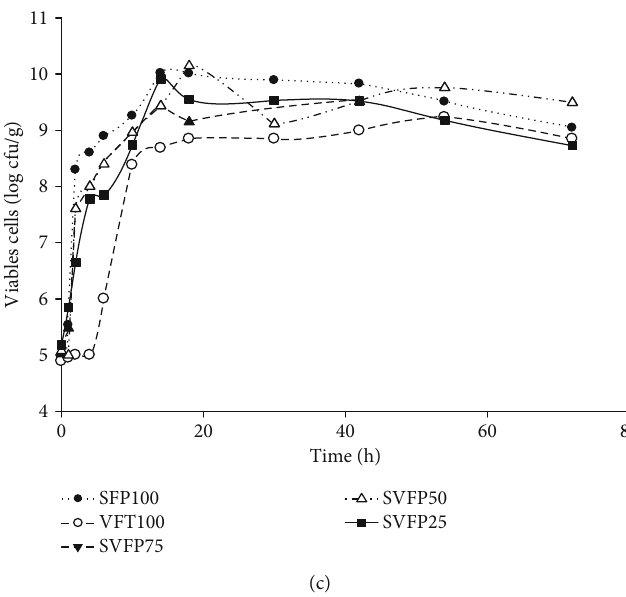
Figure 2: Evolution of pH (a), lactic acid (b), and L. plantarum A6 counts (c) during fermentation. SFP100: precooked and fermented sorghum fl our; VFT100: roasted and fermented Bambara fl our; SVFP25: fermented fl our containing 25% of precooked sorghum fl our and 75% roasted Bambara fl our; SVFP50: fermented fl our containing 50% precooked sorghum fl our and 50% roasted Bambara fl our; SVFP75: Table 1: Proximate composition of precooked fermented and unfermented fl ours.